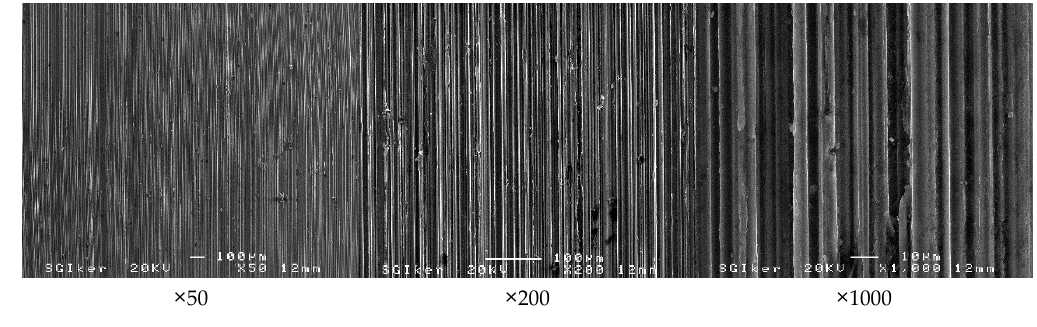
Figure 15. AA ‐ 5083 ‐ O disk.